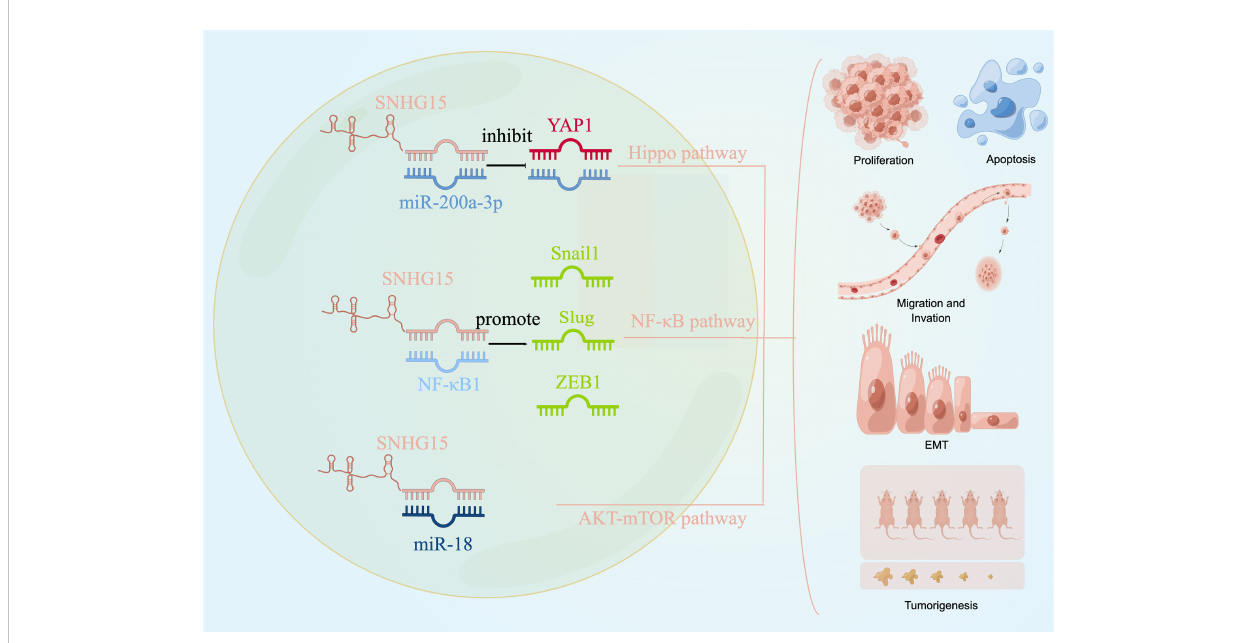
FIGURE 3 SNHG15 regulates multiple signaling pathways. SNHG15 exerted tumor-promoting effects by regulating YAP-Hippo and AKT-mTOR